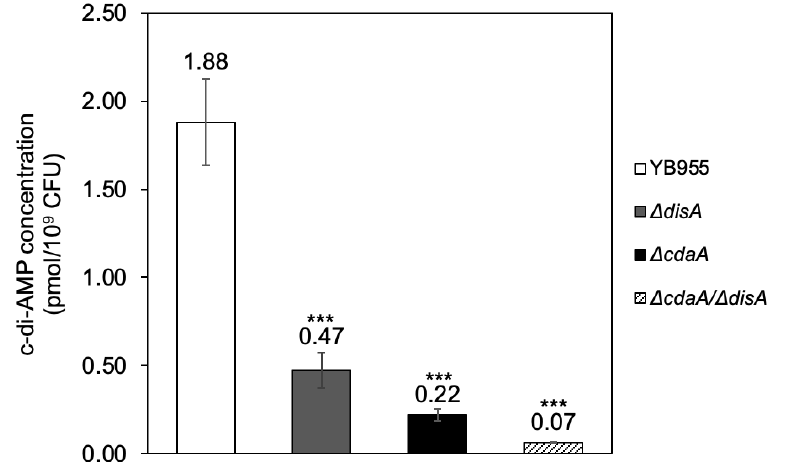
Figure 1. Intracellular c-di-AMP levels of Bacillus subtilis YB955 (open bar), ∆ cdaA (dark grey bar), ∆ disA (black bar) and ∆ cdaA / ∆ disA (hatched bar) were determined in vegetative cells (grown to an OD 600nm = 1.0) by competitive ELISA quantification as described in Materials and Methods. Data show the average from three independent determinations ± standard deviations. *** represent significant statistical differences compared to the parental strain, as determined by a one-way analysis of variance (ANOVA) and Tukey Honest Significant Difference (HSD) test ( p = 2.07 × 10 − 8 , p = 3.43 × 10 − 9 , p = 1.28 × 10 − 9 , respectively).